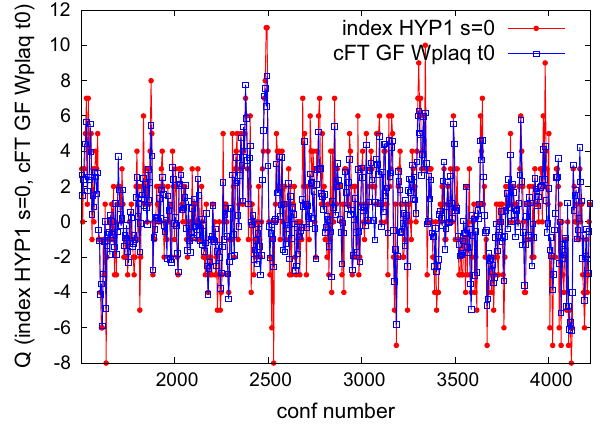
Fig. 6 Monte Carlo histories for one representative fermionic defini- tion (index of the overlap operator evaluated on configurations with 1 stepofHYPsmearingapplied)andonerepresentativegluonicdefinition (Wilson flow at flow time t 0